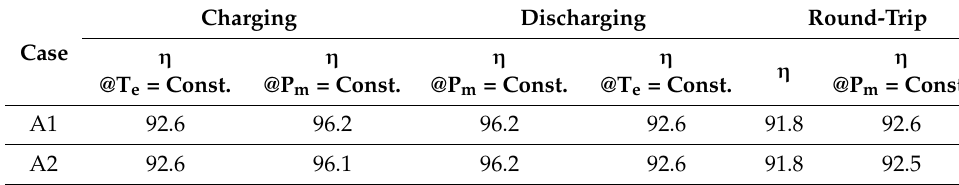
Figure 12. FESS torque ( T e ), power ( P m ), state-of-energy (SOE), and speed ( ω m ) achieved during the self-discharge test (case B1, quantities normalized to their corresponding rated values).